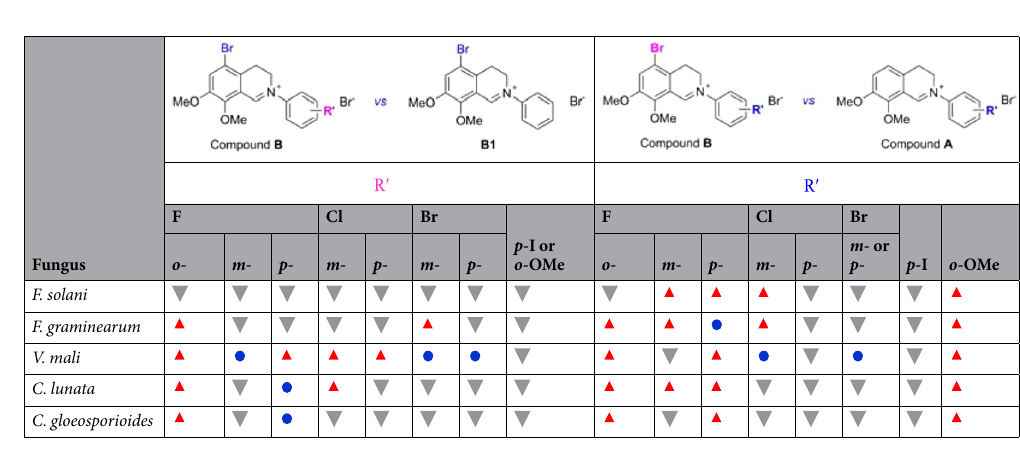
B. For the same substituent, the site of substituents on the C-ring can also significantly influence the activity (Table 3), but this impact varies with the type of substituents and species of fungi. For example, 2 ′ -brominated compound ( A8 ) showed the highest activities against F. solani , V. mali and C. gloeosporioides among three isomers ( A8 – A10 ), whereas 4 ′ -brominated compound ( A10 ) gave the highest activity against F. graminearum and C. lunata . Unlike brominated compounds, 3 ′ -F compound ( A3 ) showed the highest activity against C. lunata and C. gloeosporioides among three isomers ( A2 – A4 ). For methylate- or methoxylated compounds, only 3 ′ -Me, 4 ′ -Me or 3 ′ -OMe isomer can give improvement of the activity in most cases ( A21 , A22 , A24 , Table 2). C. The presence of double halogen atoms can obviously increase the activity compared with the corresponding mono-halogenated compounds ( A14 vs A2 – A4 ; A15 vs A5 – A7 ) (Table 3). D. Comparison of the activities of various compounds B (R = Br) and the corresponding compounds A (R = H) with the same substituents on the C-ring showed that the effect of 5-Br on the A-ring on the activity var- ies with the substitution patterns of the C-ring group. When 2 ′ -, 3 ′ - or 4 ′ -F, 2 ′ -OMe or no substituent is present on the C-ring, the introduction of 5-Br can significantly increase the activity against all or most of the fungi ( Bn vs An , n = 1, 2, 3, 4; B10 vs A23 ). However, the opposite is found when 4 ′ -Cl, 3 ′ -Br, 4 ′ -Br or 4 ′ -I is present ( B7 vs A9 ; B8 vs A10 ; B9 vs A13 ). When R ′ is 3 ′ -Cl, the introduction of 5-Br only makes a small influence on the activity against all the fungi ( B6 vs A7 ) (Table 5). The results above show that there is an interaction effect between substituents on the A-ring and the C-ring, and the activity of compounds depends on the combined effect of substituents on both the A-ring and the C-ring. A similar case was found for the antifungal activity of 6-chloro-ADHIQs 9 and 8-methoxy-ADHIQs 11 reported previously by us. The facts above strongly suggest that the bioactivity of the compounds should be related with the electron density distribution of the conjugated system. Therefore, it is necessary to extend the modification of the A-ring to discover more potent ADHIQs agents.